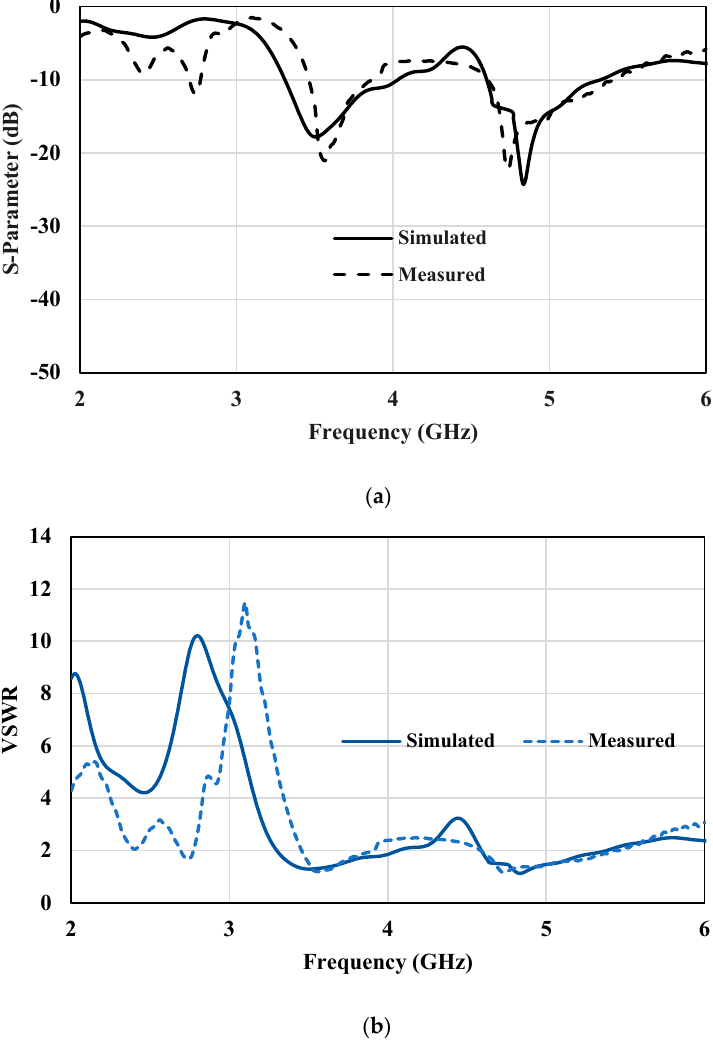
Figure 7. Measured results of the proposed antenna: ( a ) return − loss, ( b ) VSWR.